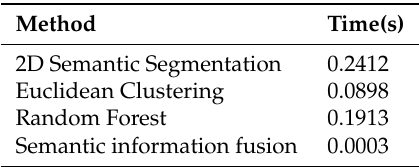
Table 2. Time analysis of the proposed